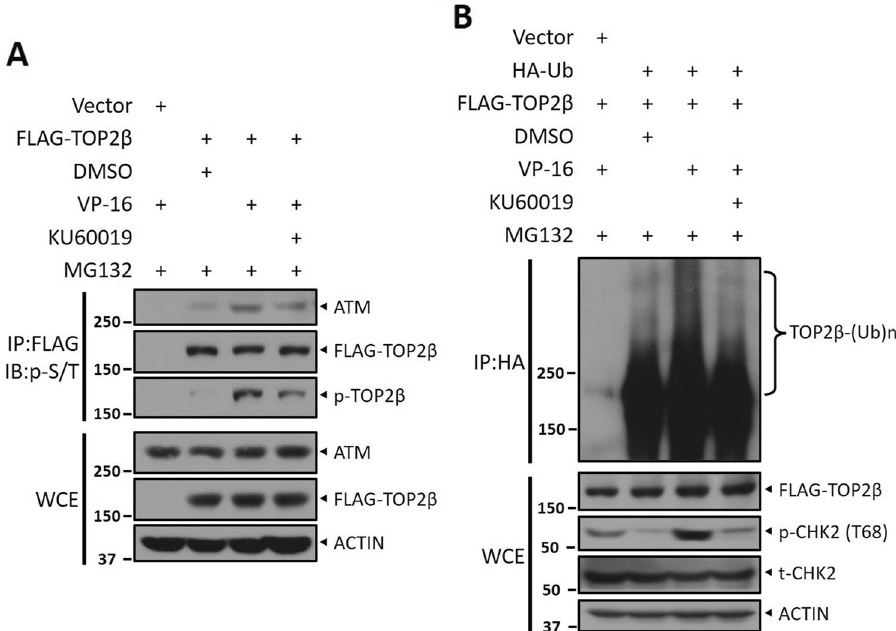
Figure 3. KU60019 interferes with the association of ATM with TOP2β and blocks TOP2β ubiquitination. ( A , B ) HEK293 cells were transfected with Flag-TOP2β for 48 h, then treated with KU60019 or vehicle combined with VP-16 and MG132 (20 μM) for 5 h, followed by IP with Flag beads and IB with the relevant antibodies. ( C , D ) HEK293 cells transfected with the specified plasmids were treated with VP-16 and MG132 (20 μM) or in association with RG7112 (5 μM) for 5 h, and then IP was performed with anti-HA beads, and direct IB was performed with the selected antibodies. All experiments were independently repeated three times. According to the molecular weight, the nitrocellulose membrane was cut prior to hybridization with antibodies and the original blots are presented in Supplementary Fig. 3. Molecular weight markers are noted to the left of blot